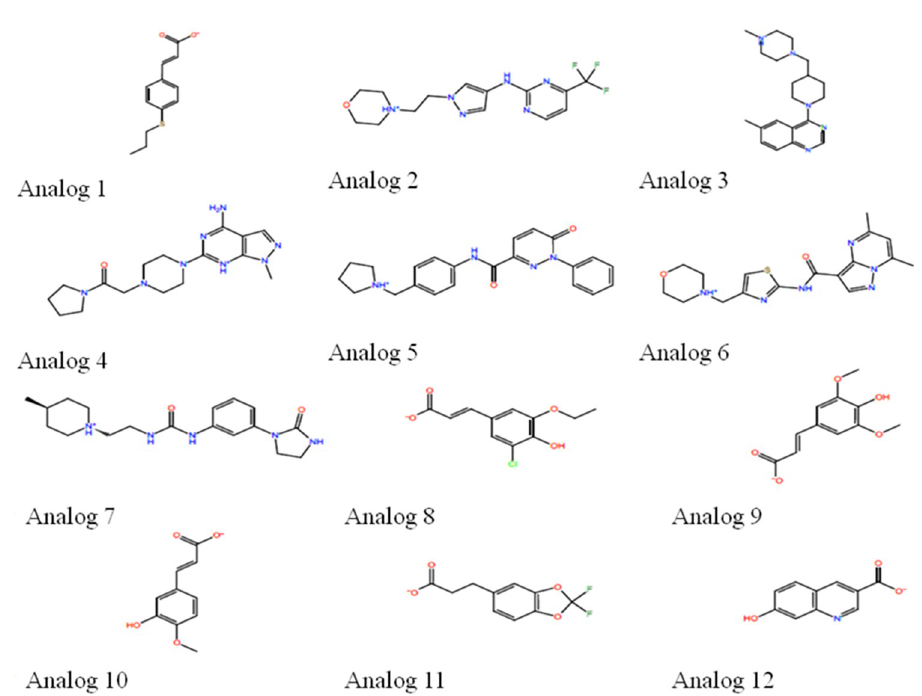
Fig 7. Molecular structures of designed